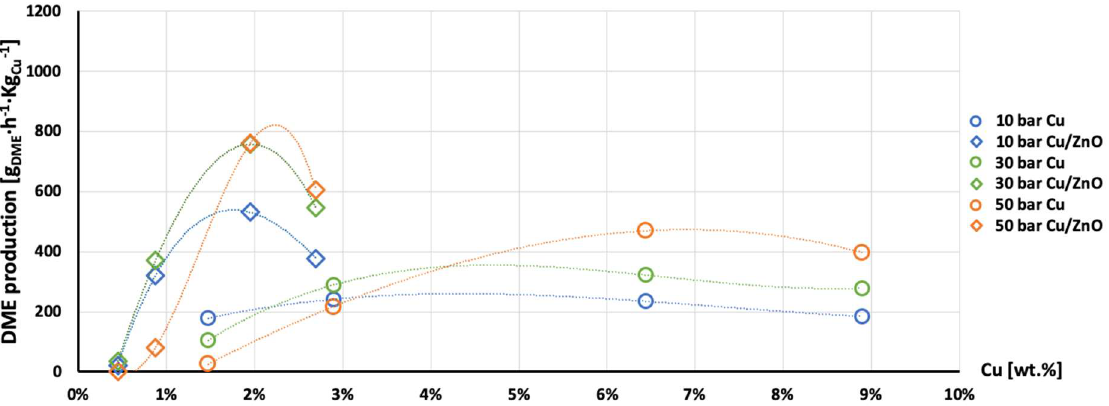
Figure 12. Production of DME per gram of Cu as a function of Cu wt. % content in AlNFs-Cu (circle dots) and AlNFs-1Cu2.3Zn (rhombic dots) catalysts at pressures of 10 (blue), 30 (green), and 50 (orange) bar at temperature 300 °C.